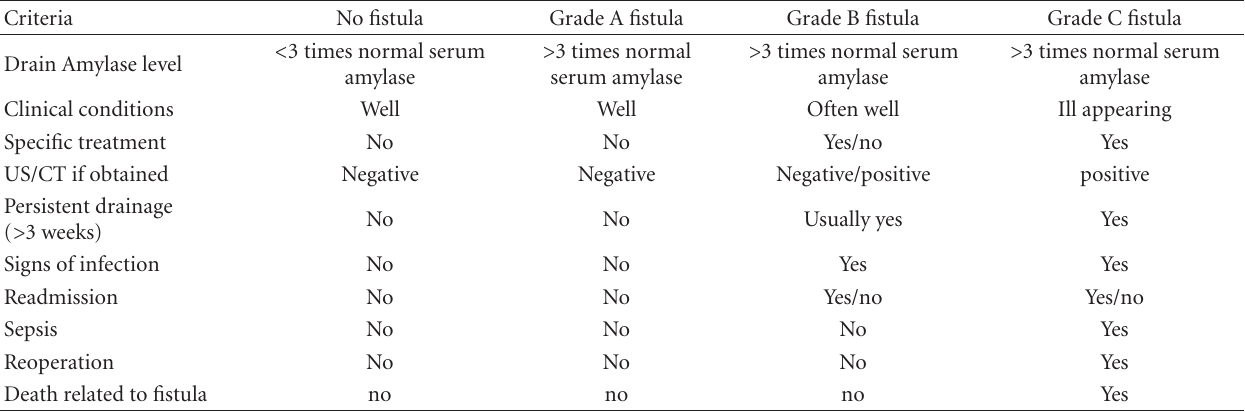
Table 2: Criteria for grading pancreatic fistula (ISGPF classification scheme). Signs of infection include elevated body temperature > 38 ◦ C, leukocytosis and localized erythema, induration, or purulent discharge. Readmission is any hospital admission within 30 days following hospital discharge from the initial operation. Sepsis is the presence of localized infection and positive culture with evidence of bacteraemia (i.e., chills, rigors, elevated WBC) requiring IV antibiotic treatment, or hemodynamic compromise as demonstrated by high cardiac output and low SVR within 24h of body temperature > 38 ◦